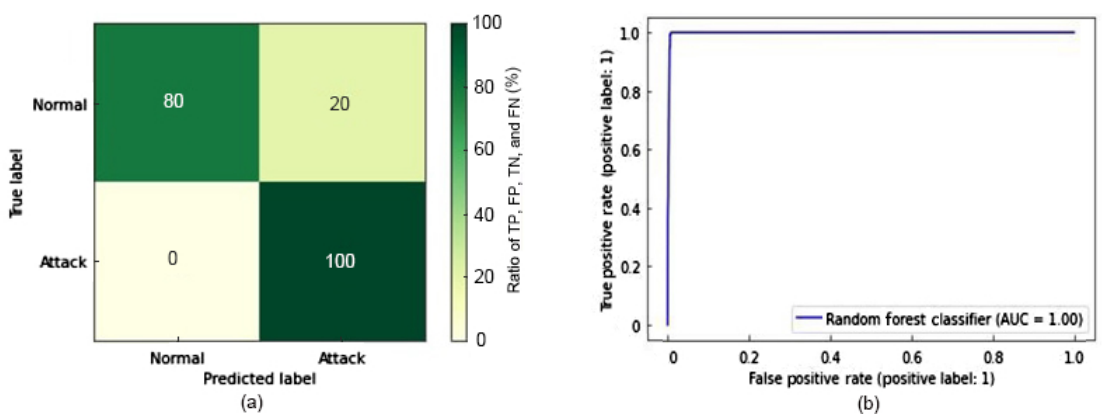
Fig. 6 Confusion matrix and ROC curve of RF-IF on the Bot-IoT